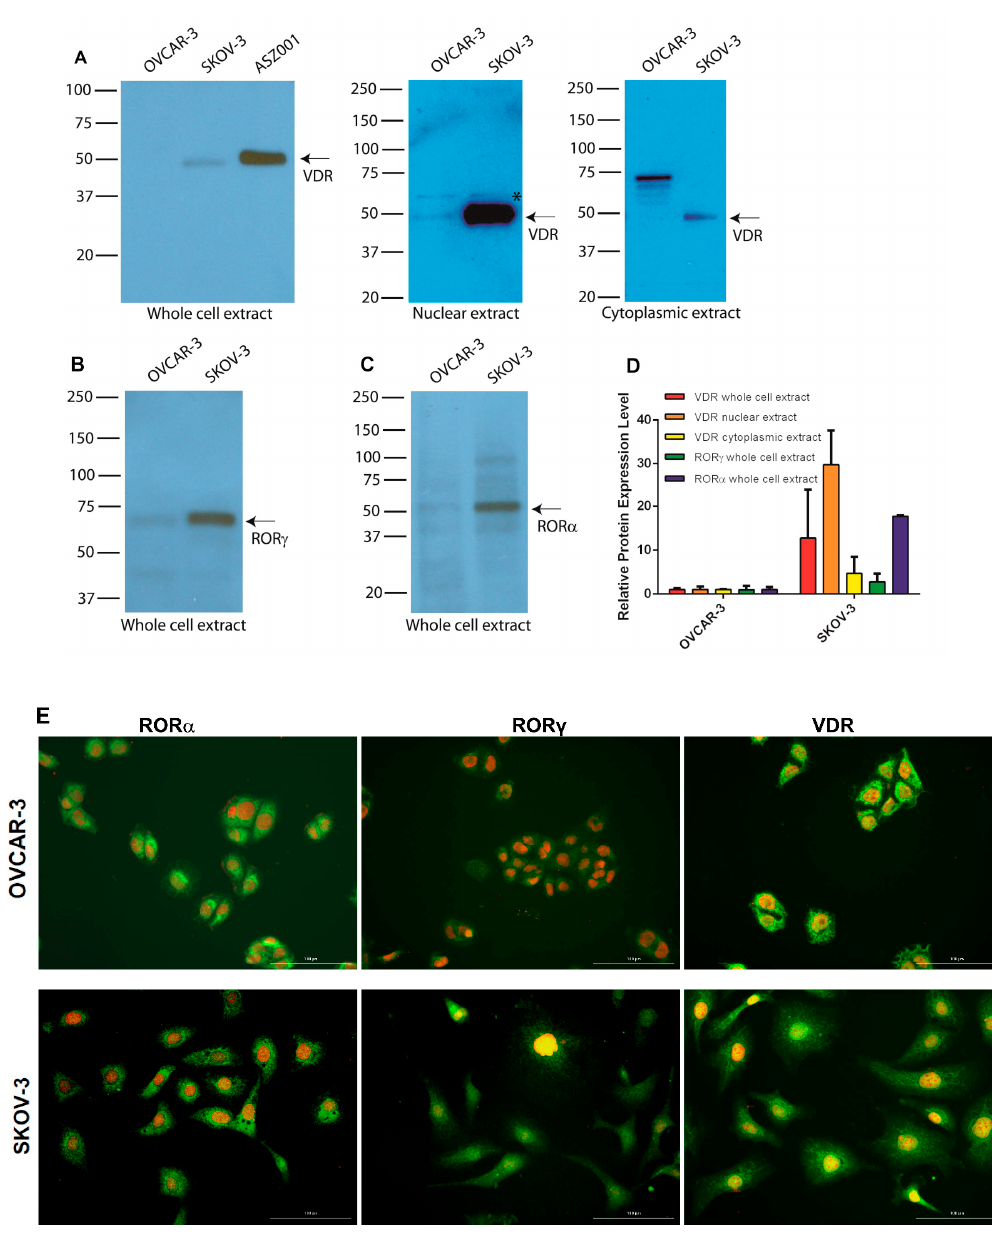
Figure 6. ROR α , ROR γ , and VDR in OVCAR-3 and SKOV-3 ovarian cancer cells. Expression of VDR and ROR α / γ in ovarian cancer cell lines as assessed by Western blot (WB): ( A ) VDR; ( B ) ROR γ ; ( C ) ROR α . ( D ) Relative protein expression in OVCAR-3 and SKOV-3 as measured by WB in whole-cell extracts ( n = 2) and nuclear ( n = 2) and cytoplasmic ( n = 2) fractions. ASZ001 (mouse basal carcinoma cell line) was used as a positive control for VDR expression in panel ( A ). ( E ) Immunofluorescence detection of ROR α , ROR γ , and VDR in OVCAR-3 and SKOV-3 ovarian cancer cells. Scale bars = 100 µ m. * p <